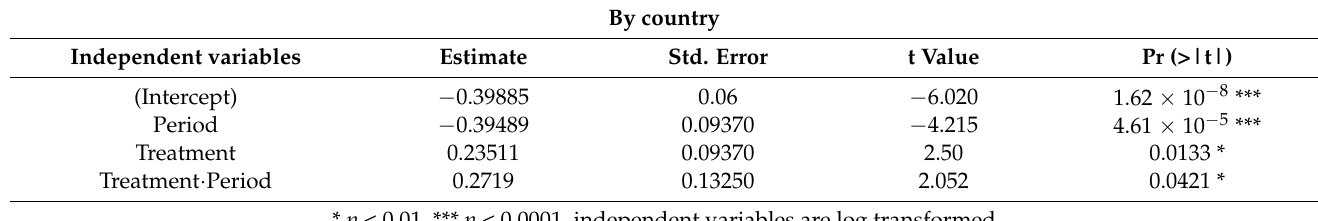
Table A2. Statistics of Difference-in-Differences analysis to calculate avoided deforestation by country and individuals.